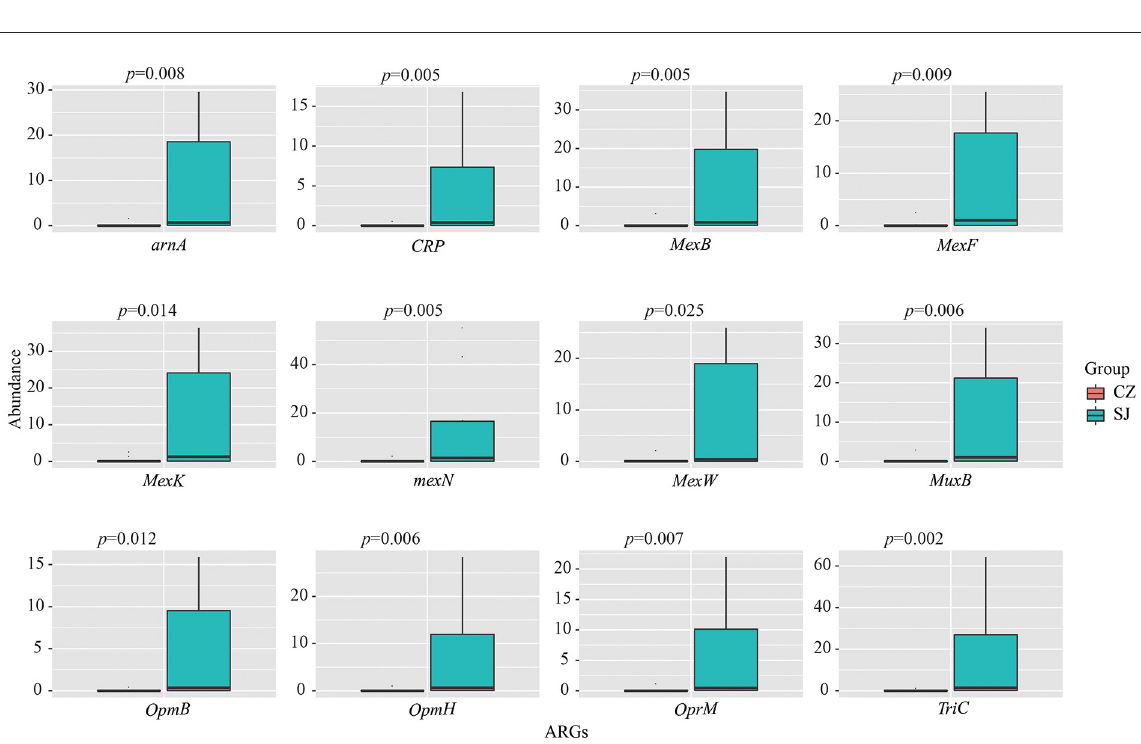
and groundwater of the study area were higher than those of atmospheric precipitation, while total phosphorus, total